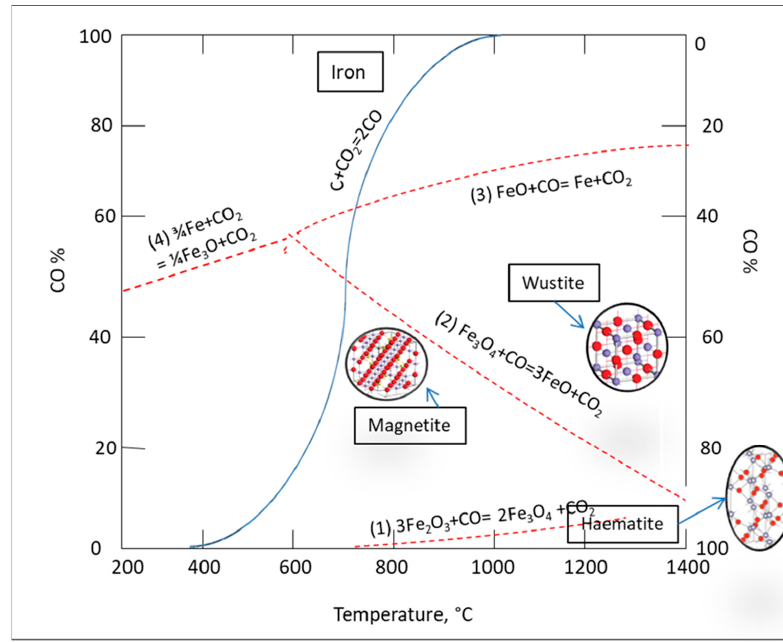
Figure 2. Roasting and reduction processes. Adapted from Ref. [24]